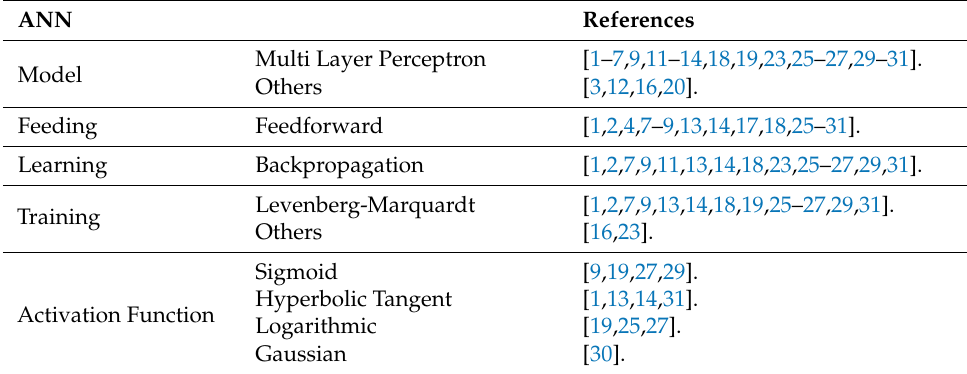
Table 2. Characterization of ANN in fault location